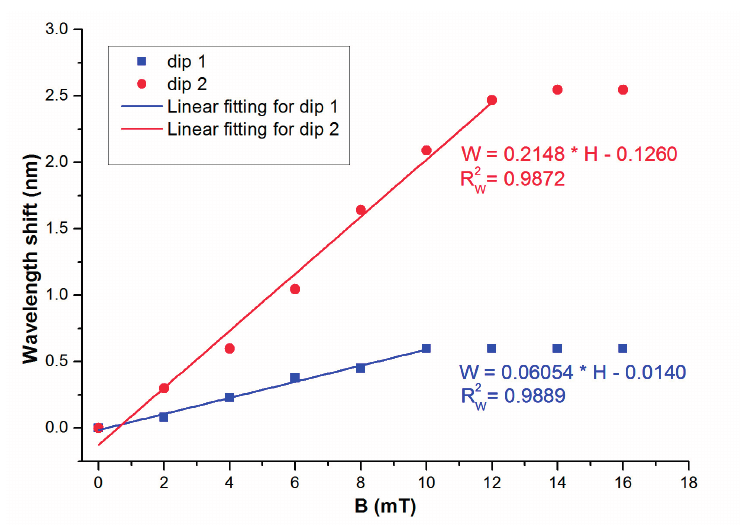
Figure 6. Wavelengths of dips 1 and 2 change with magnetic